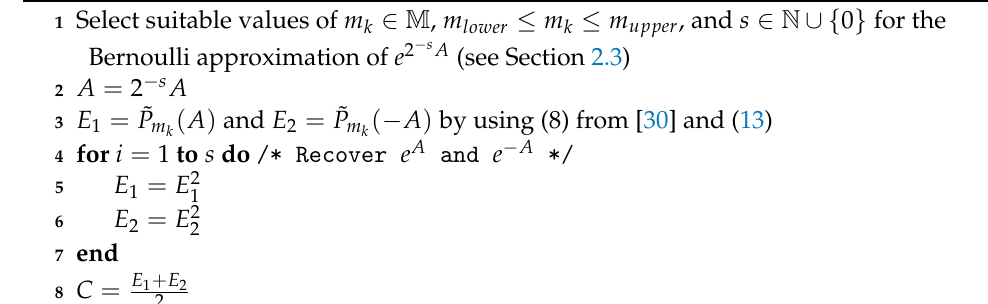
Algorithm 3: Given a matrix A ∈ C r × r , a minimum order m lower ∈ M and